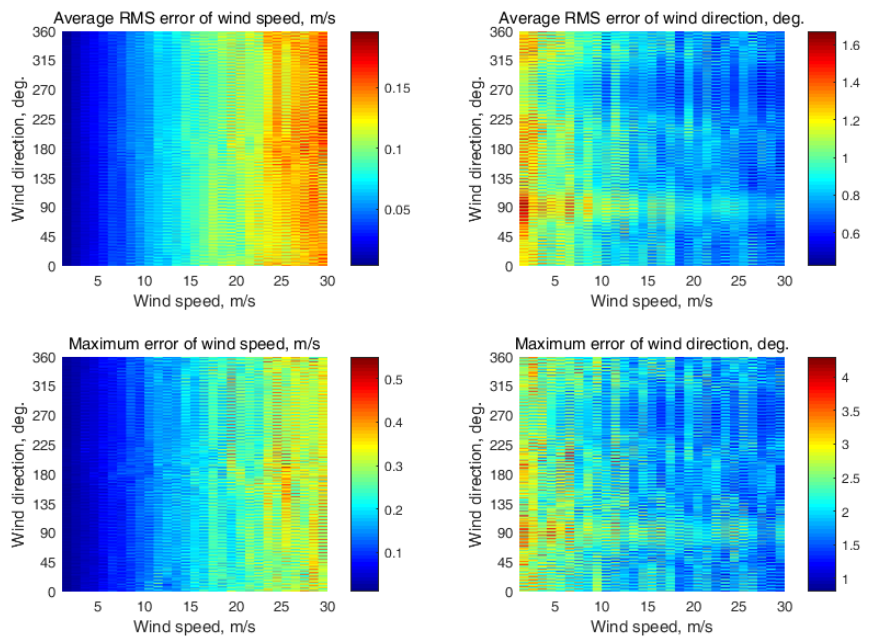
Figure A20. Semicircular wind retrieval results at the (30°, 35°, 40°, 45°) incidence angle combination.